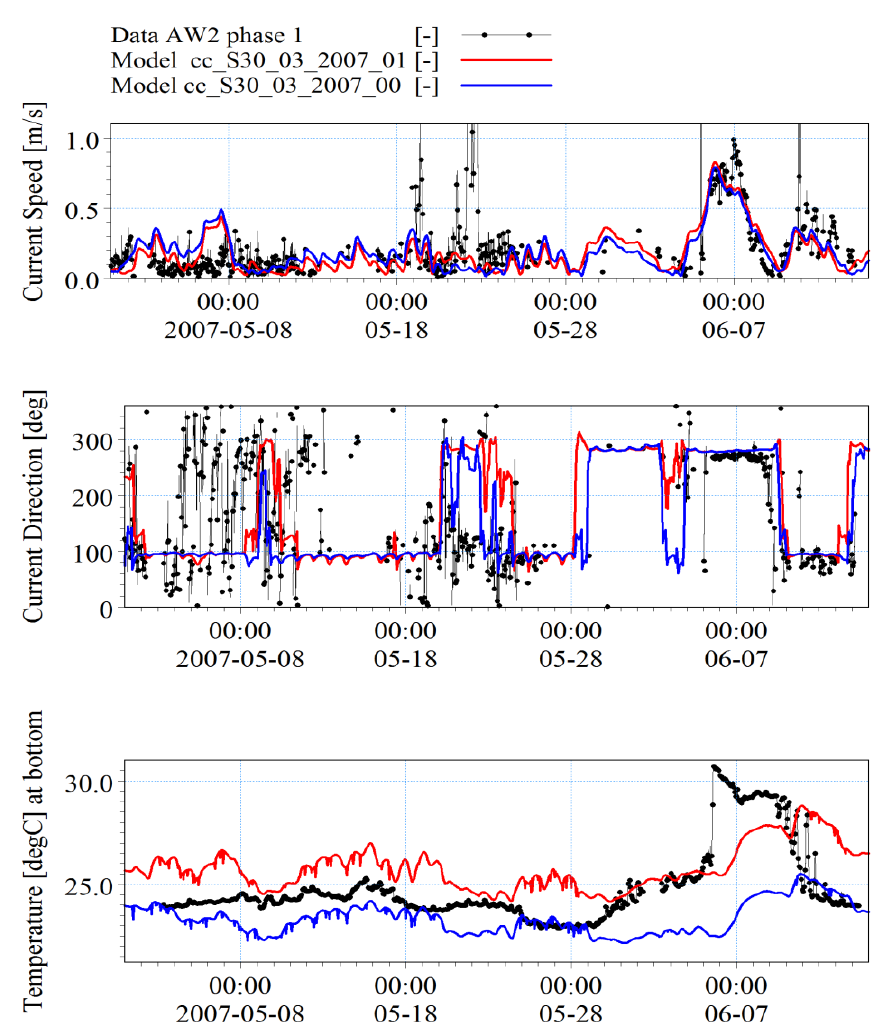
Figure 13. Comparisons between AW2 data (black) and model results (red) during cyclone